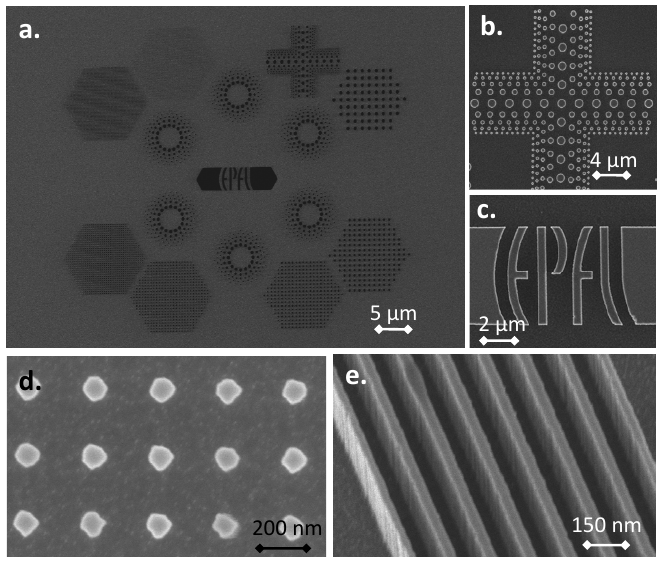
Figure 3. SEM micrographs showing fabrication results. ( a ) Detail of a nanostencil membrane. ( b ) and ( c ) show some of the patterns in ( a ) after the transfer to the Si has been performed. ( d ) and ( e ) show the parts of the stamp with the smallest size designs (100 nm in diameter pillars; 50 nm wide lines). Stamp features’ dimensions lie within ±10 nm of the stencil apertures’